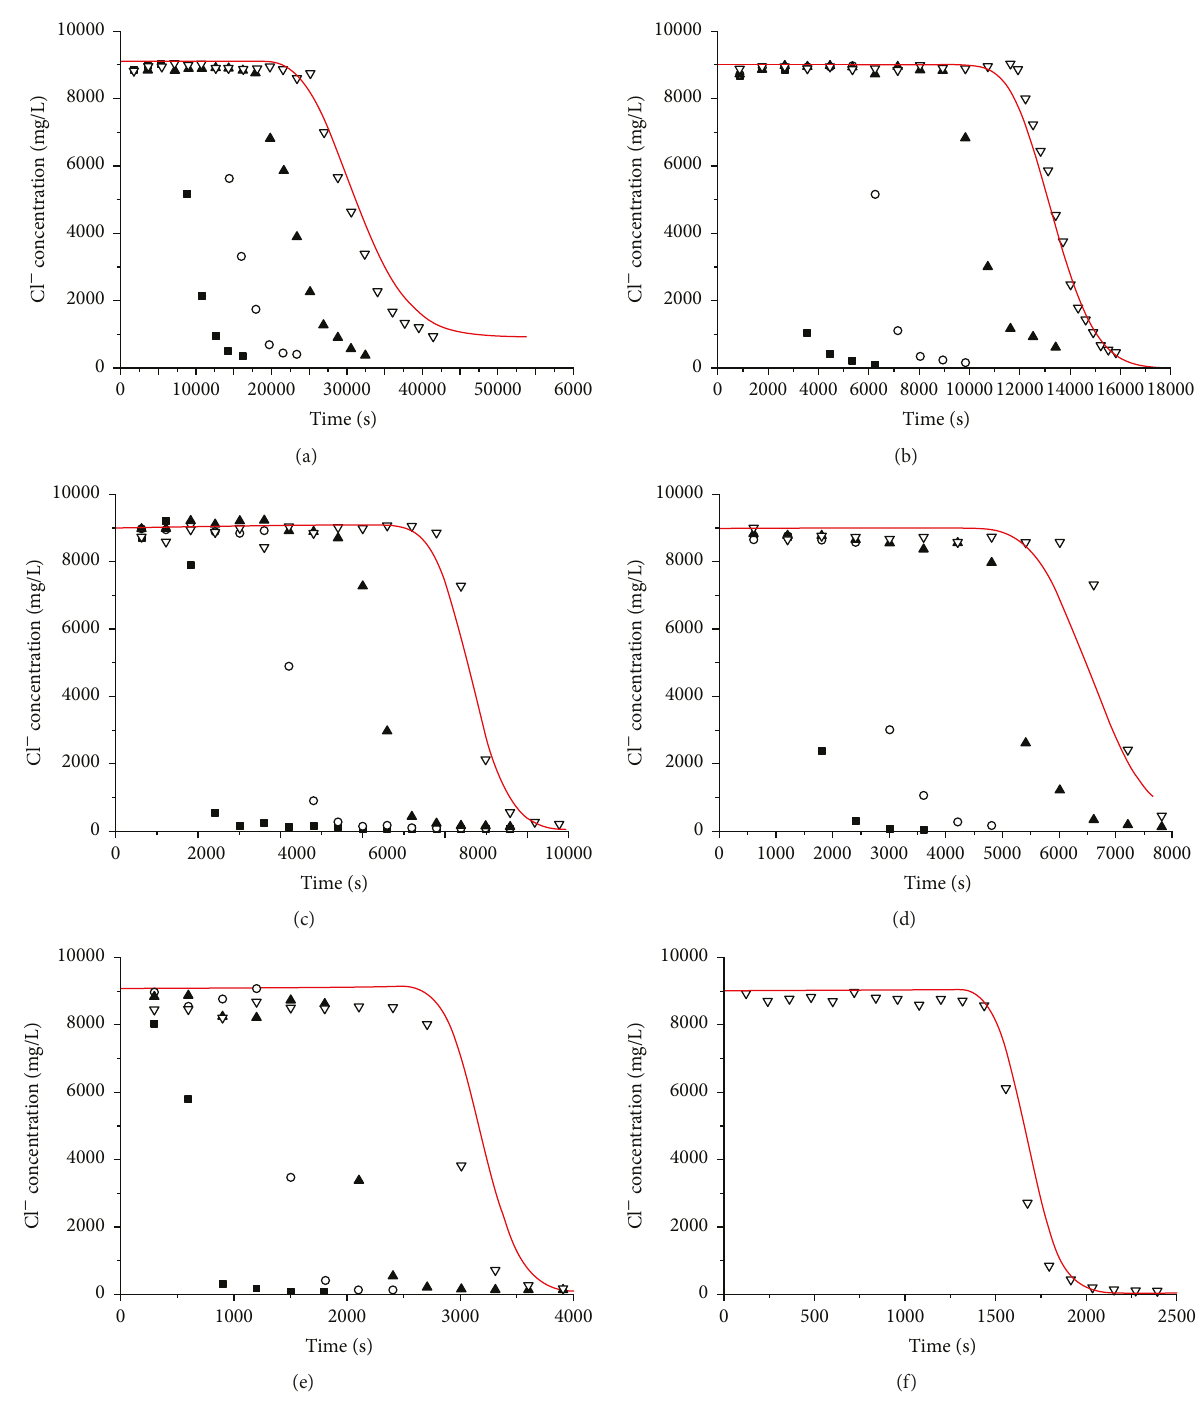
Figure 3: Curves and fi tting results of Cl - at the monitoring point and outlet indi ff erent gravity direction: (a) 2mL/min, (b) 5mL/min, (c) 8mL/min, (d) 10mL/min, (e) 20mL/min, and (f) 40